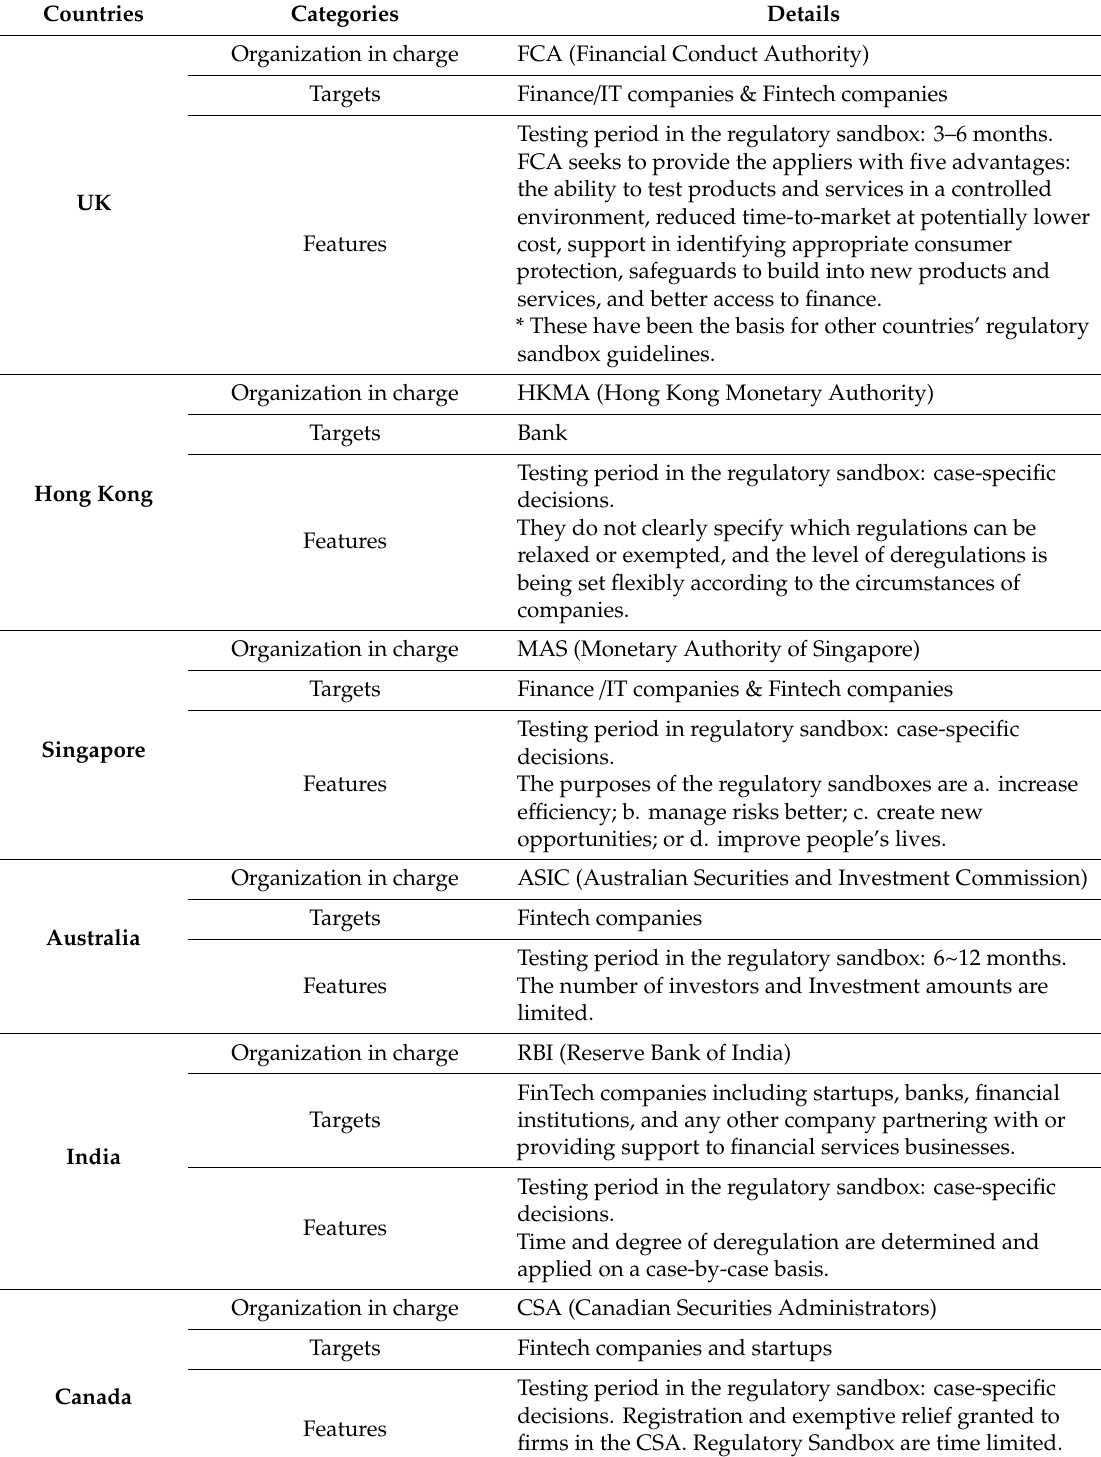
Table 2. Features of each country’s fintech regulatory sandbox (based on the guidelines of the financial authorities’ reports